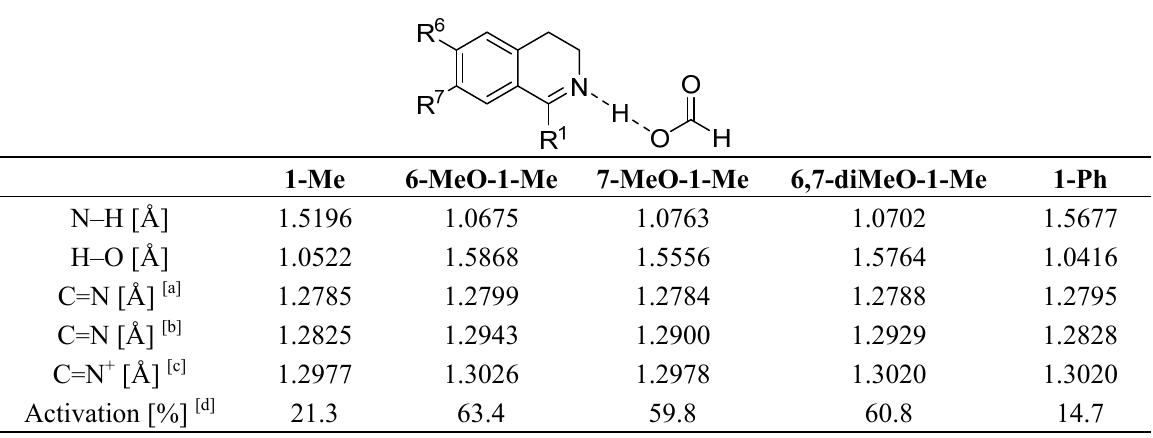
Table 3. Calculated interatomic distances for the proton located between the nitrogen of the imine substrate and oxygen of the formate anion [38] [a]